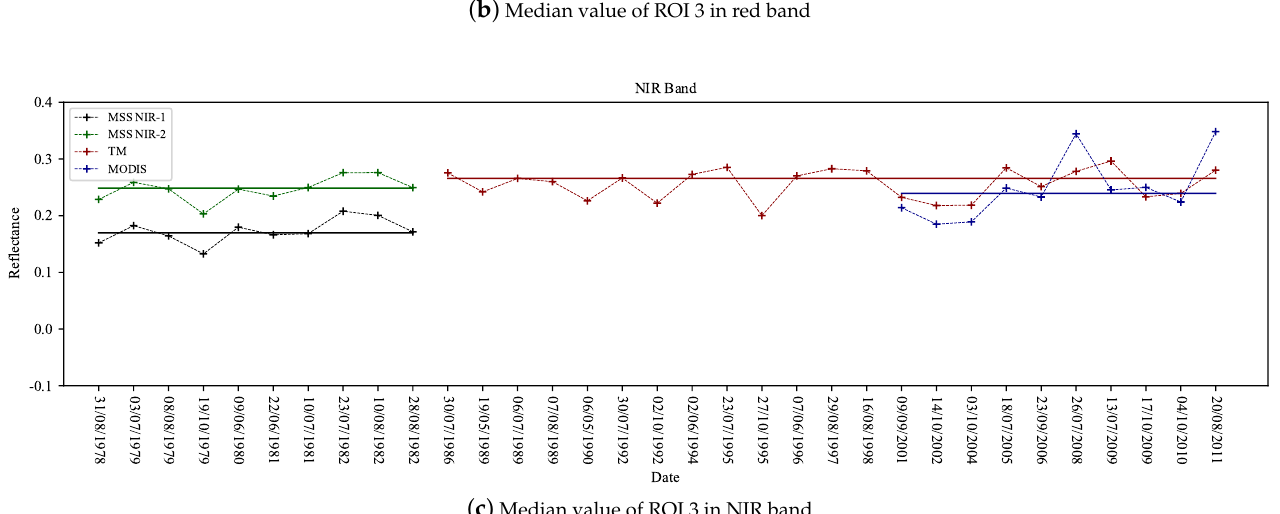
( b ) Median value of ROI 3 in red band